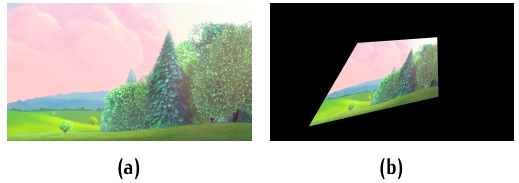
Figure 3. Homography results. (a) Original image. (b) Deformed